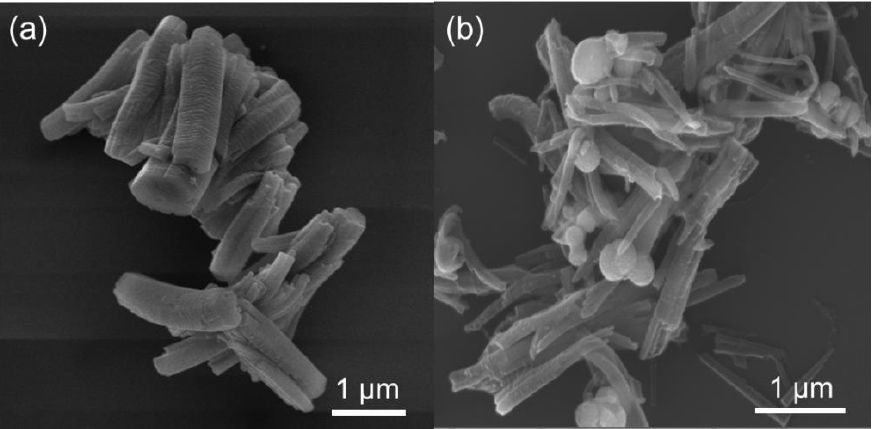
Figure 1. SEM images of MIL-68(Ga) ( a ) and magnetic MIL-68(Ga) ( b